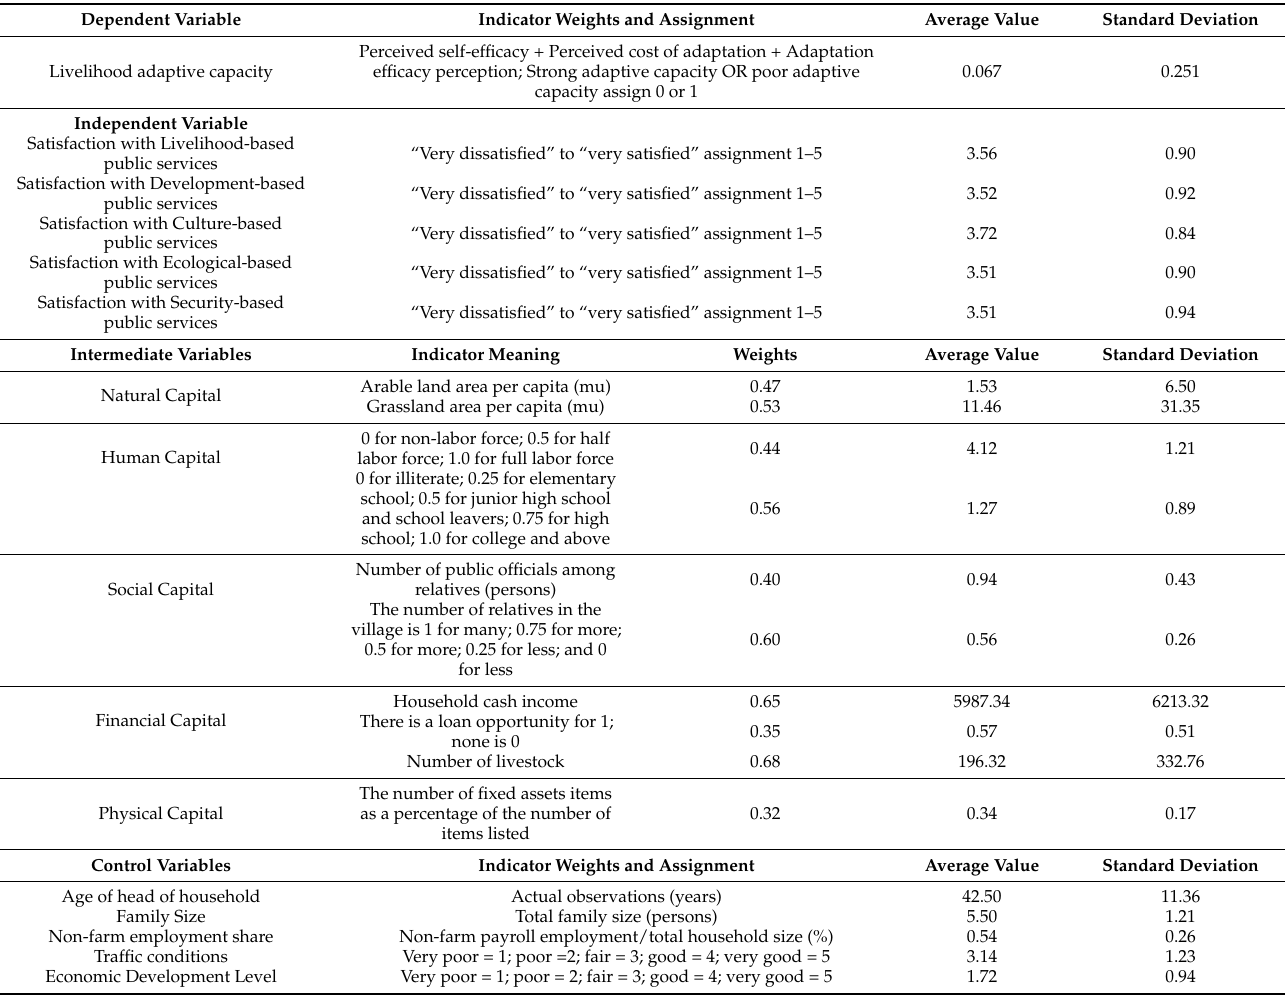
Table 3. Definitions of variables and descriptive